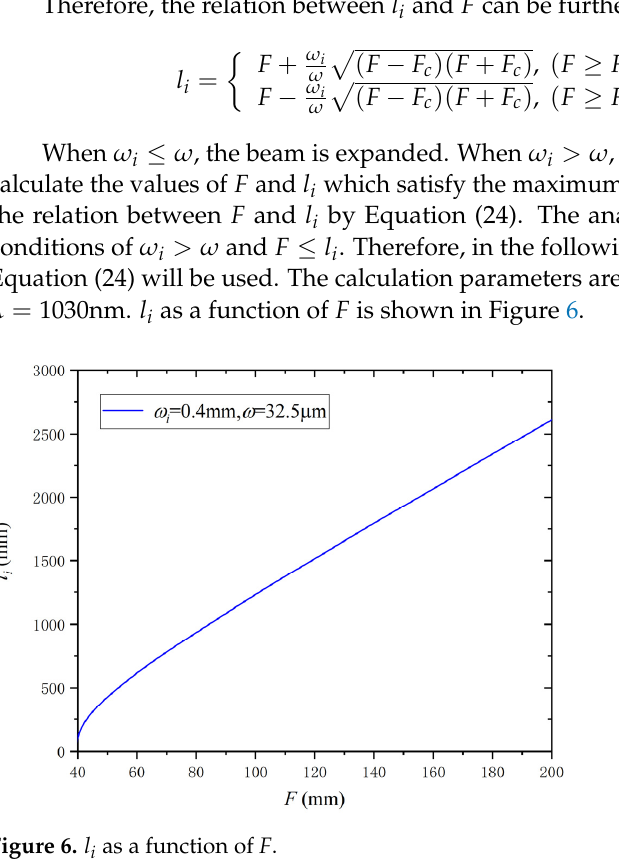
l Figure 6. i as a function of F